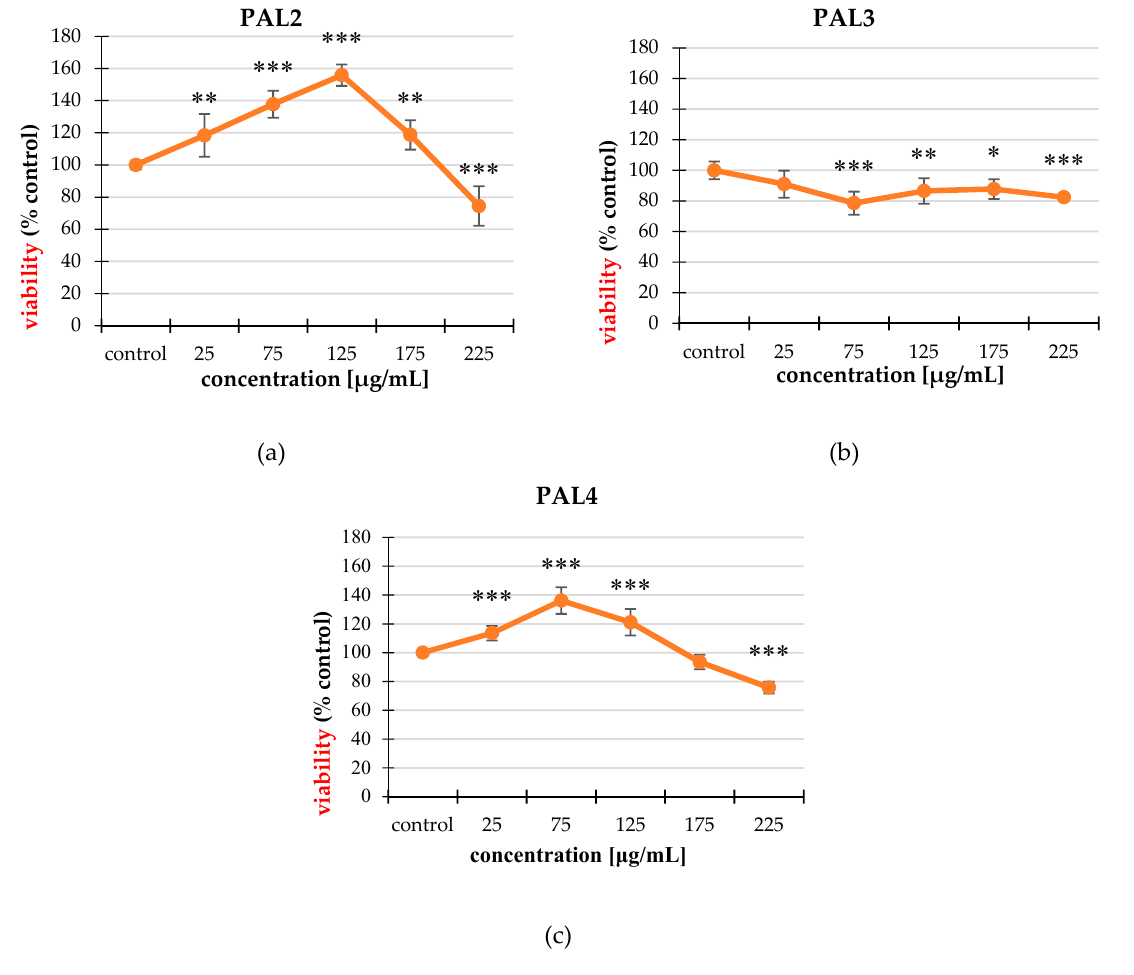
Figure 2. The cytotoxic properties of the tested extracts of the HT-29 line studied using an 3-(4,5-dimethylthiazol-2-yl)-2,5-diphenyltetrazolium bromide (MTT) assay. The most effective extracts were PAL2 ( a ), PAL3 ( b ), PAL4 ( c ). The values are compared to the control regarded as 100%; * p < 0.01, ** p < 0.005, *** p < 0.001, one-way ANOVA, Dunnett’s test.